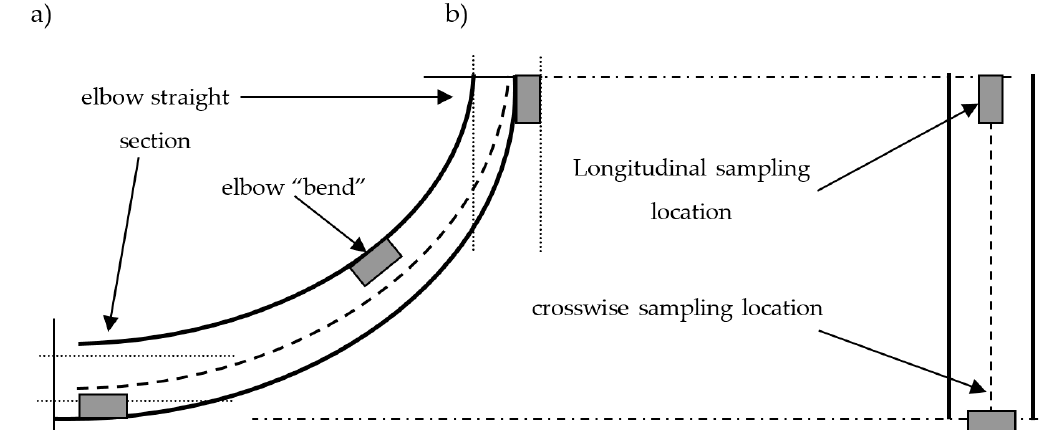
Figure 1. Steam pipe elbow: ( a ) area of sampling; ( b ) sample location method